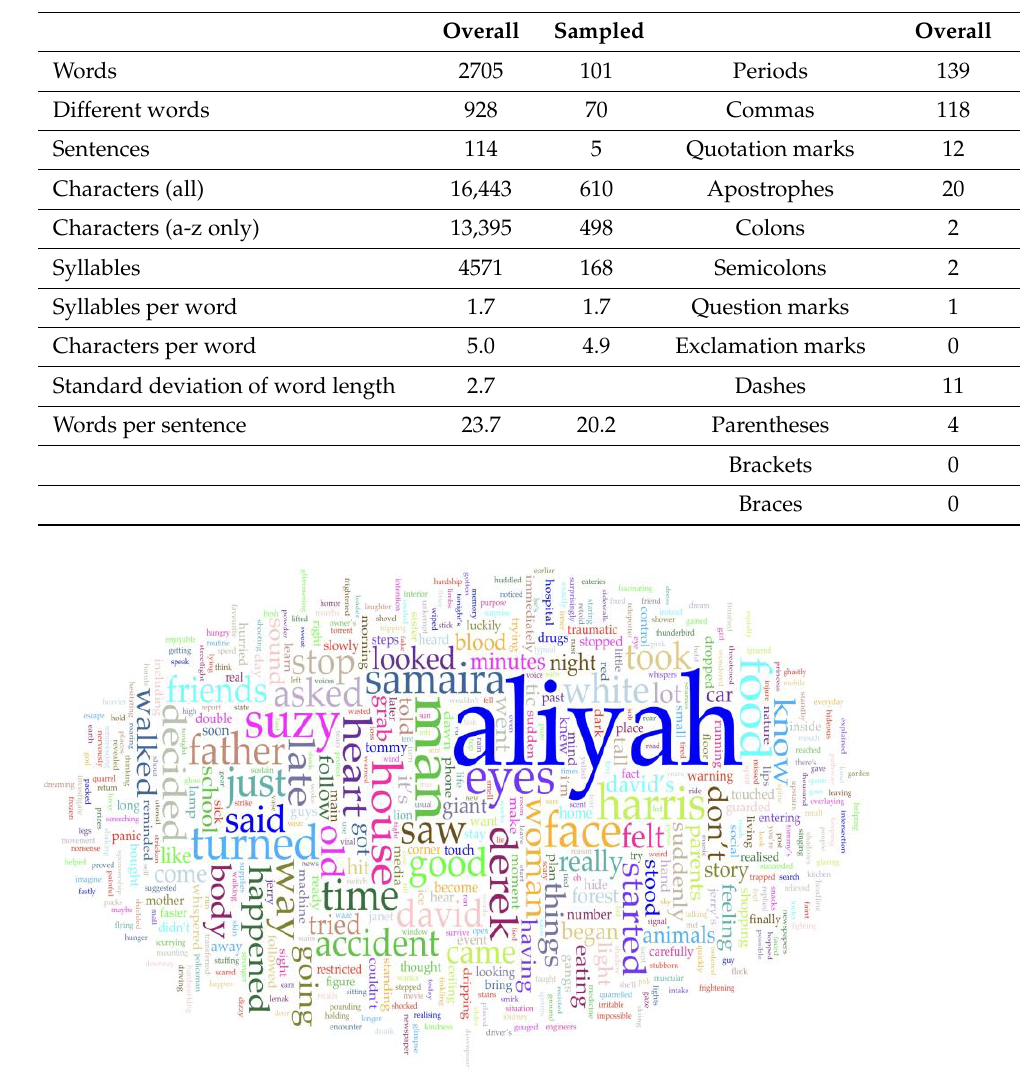
Figure 2. Word cloud for storyboarding (Source: Voyant Tools).